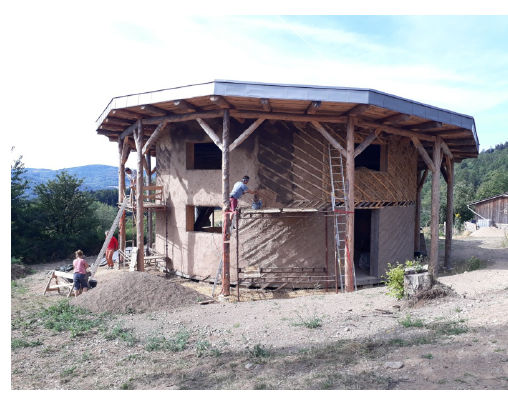
Figure 2. Building of family house from straw and earth in Klášterecká